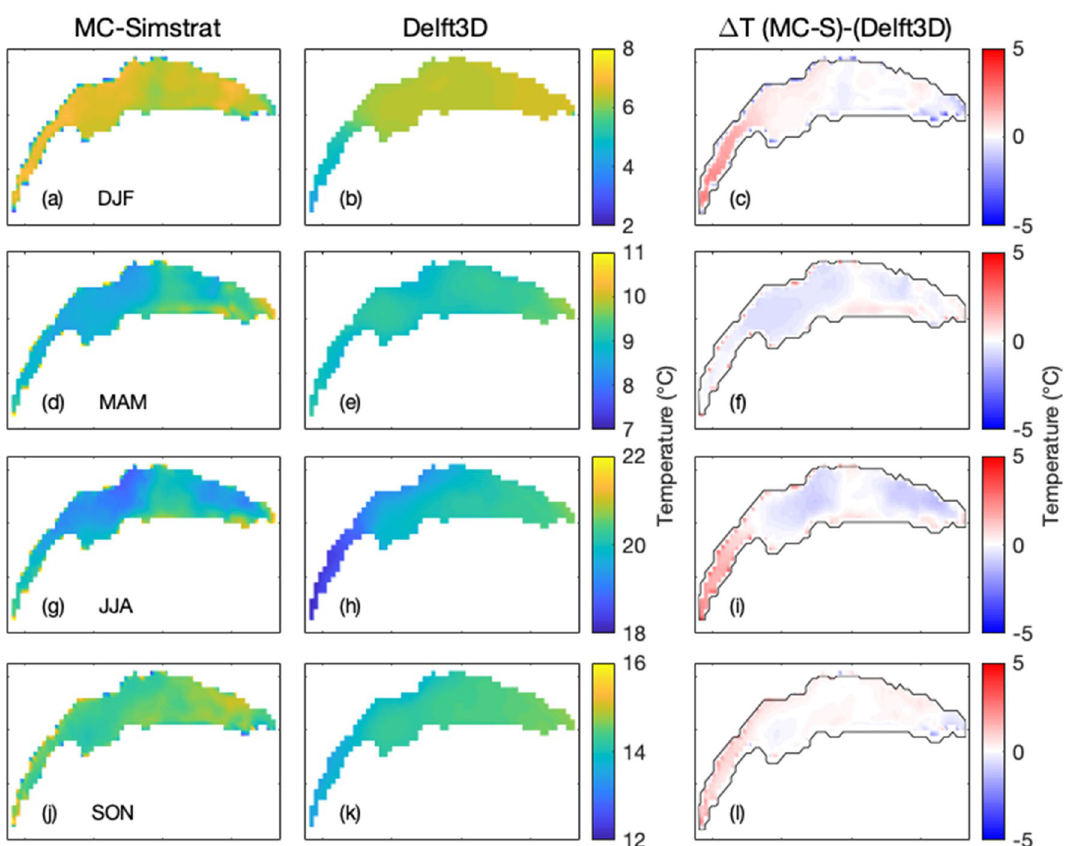
Figure 6. Seasonally-averaged surface (0 m) temperature maps from the MCM (col 1), Delft3D (col 2), and their difference (MCM—Delft3D) (col 3). ( a – c ) Winter (DJF), ( d – f ) Spring (MAM), ( g – i ) Summer (JJA), ( j – l ) Autumn (SON). Lake contours are indicated in Col. 3 for clarity. Plots generated with Matlab 25 ; Panels assembled with Adobe Illustrator 26